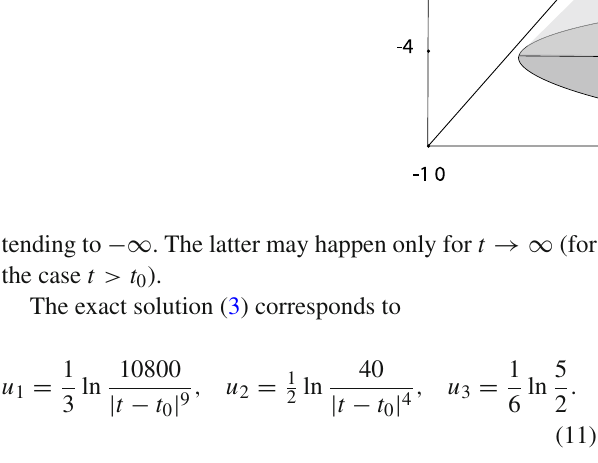
Fig. 1 The lower half-cone − ˙ u 2 − 3 ˙ u 2 > 0. The with 3 ˙ u 2 1 2 3 dynamics of the system takes place inside the cone. The exact solution (3) is shown as the line (the arrow indicates the direction of evolution), which lies in the axial plane ˙ u 3 = 0 and satisfies ˙ u = 2 ˙ u → ∞ , the line 2 1 . For t 3 tends to the vertex of the cone. The other end of the line extends to infinity (which is beyond the scope of the BKL scenario)